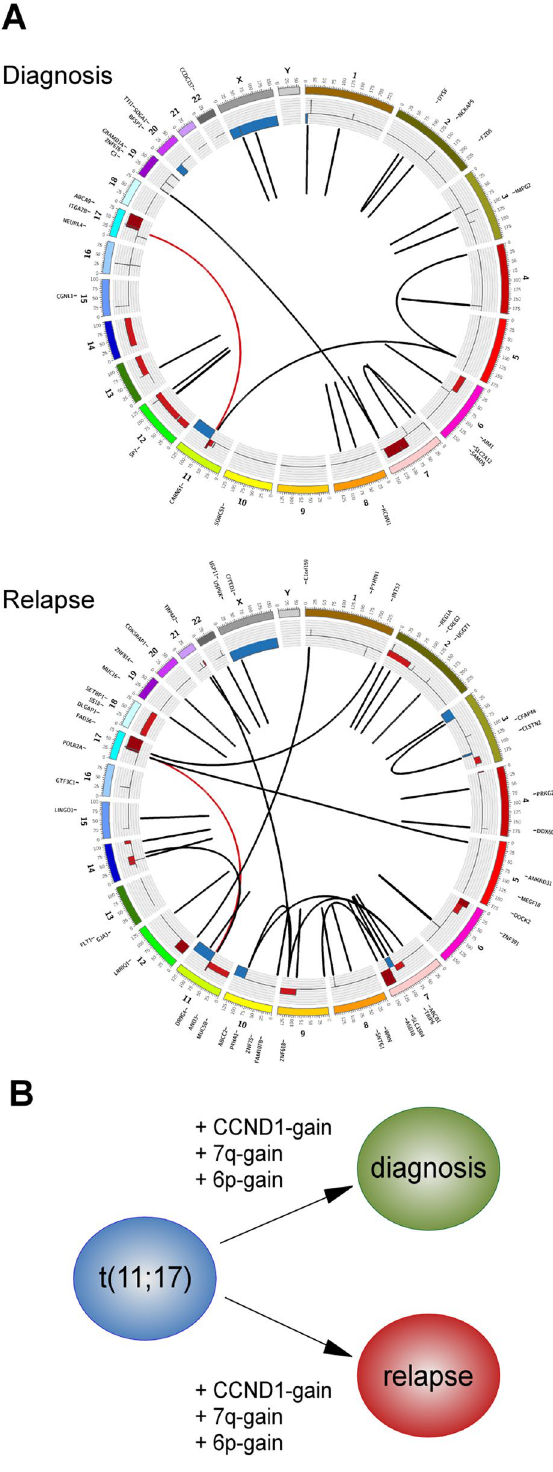
Figure 3. Broad patient-specific tumor heterogeneity with converging genomic alterations. ( A ) Striking tumor heterogeneity is seen between tumor material from time of diagnosis and time of relapse in patient NB60R6. Only one SV, an unbalanced translocation between chromosomes 11 and 17, is shared by the two samples. ( B ) The two samples display converging genomic events, such as gain of CCND1 , 7q, and 6p, albeit with different breakpoints and different parental